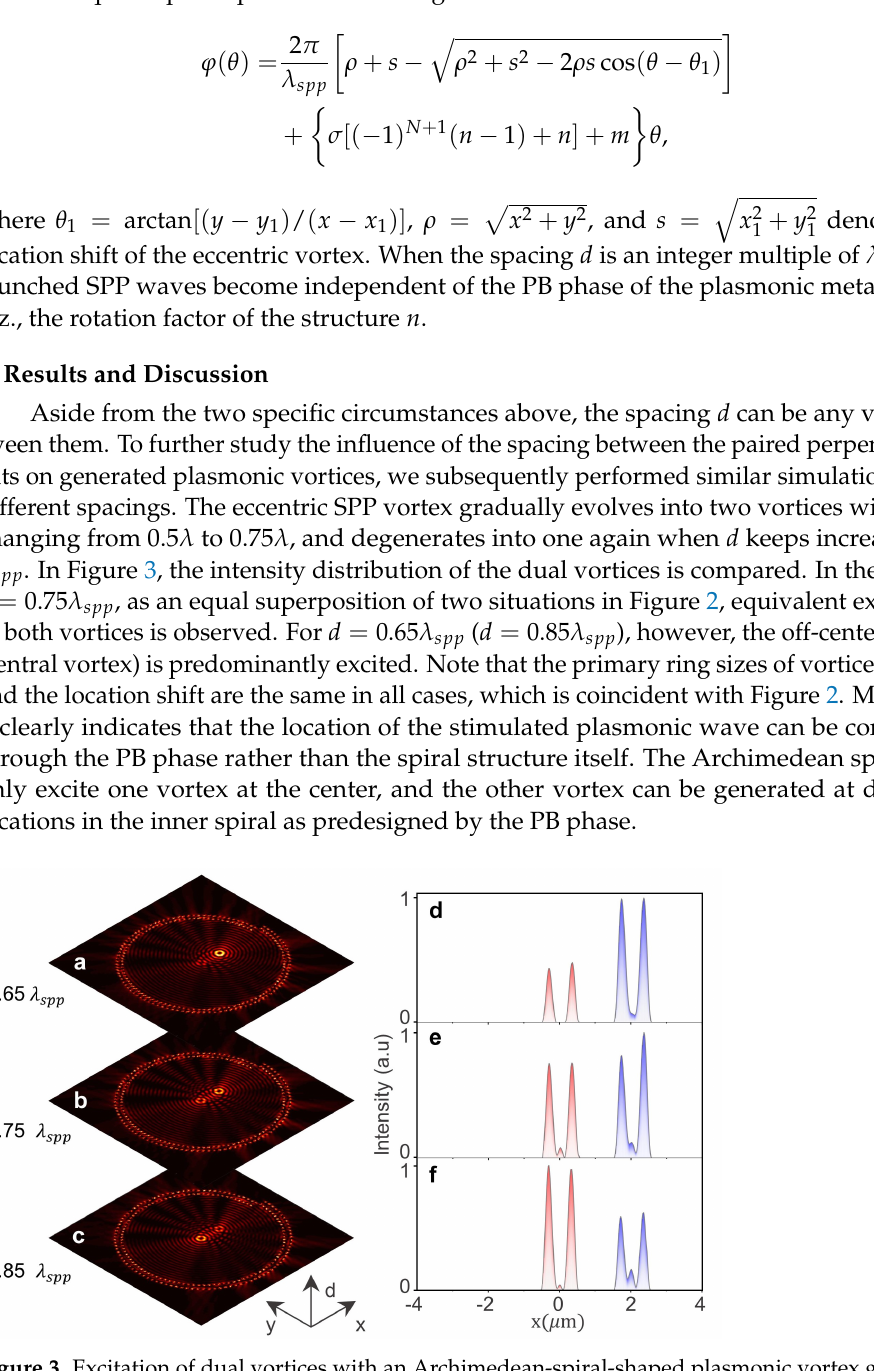
Figure 3. Excitation of dual vortices with an Archimedean-spiral-shaped plasmonic vortex generator. ( a – c ) Intensity distributions of launched SPP waves for different d under illumination of a right- handed circularly polarized light. ( d – f ) Normalized cross-sections of the intensity profiles at y = 0, showing the dependence of excited SPP vortices on the spacing of each paired